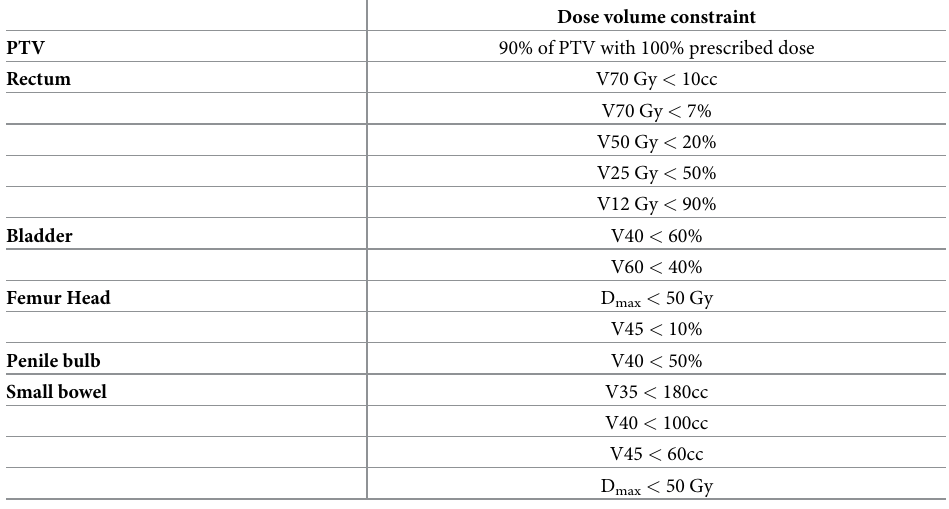
Table 1. Dose-volume constraints for the PTV and OARs.